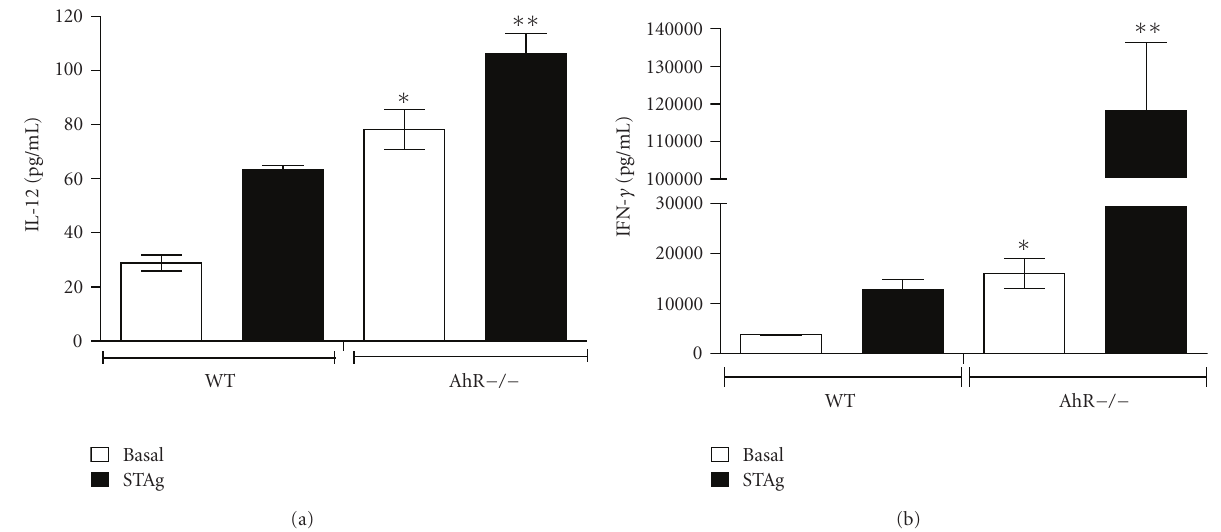
Figure 5: IL-12 and IFN- γ levels of PECs from T. gondii -infected AhR-/- and WT mice. After 25 days of T. gondii infection, PECs from AhR- /- or WT mice were recovered and restimulated in vitro with 2.5 μ g/mL of STAg for 24 hours. The IL-12 and IFN- γ levels were determined by ELISA-sandwich on supernatants recovered from cultures. Means + SE, n = 5 . ∗ P < . 05 with respect to basal bars values. ∗∗ P < . 05 with respect to STAg stimulus, Student’s t -test.